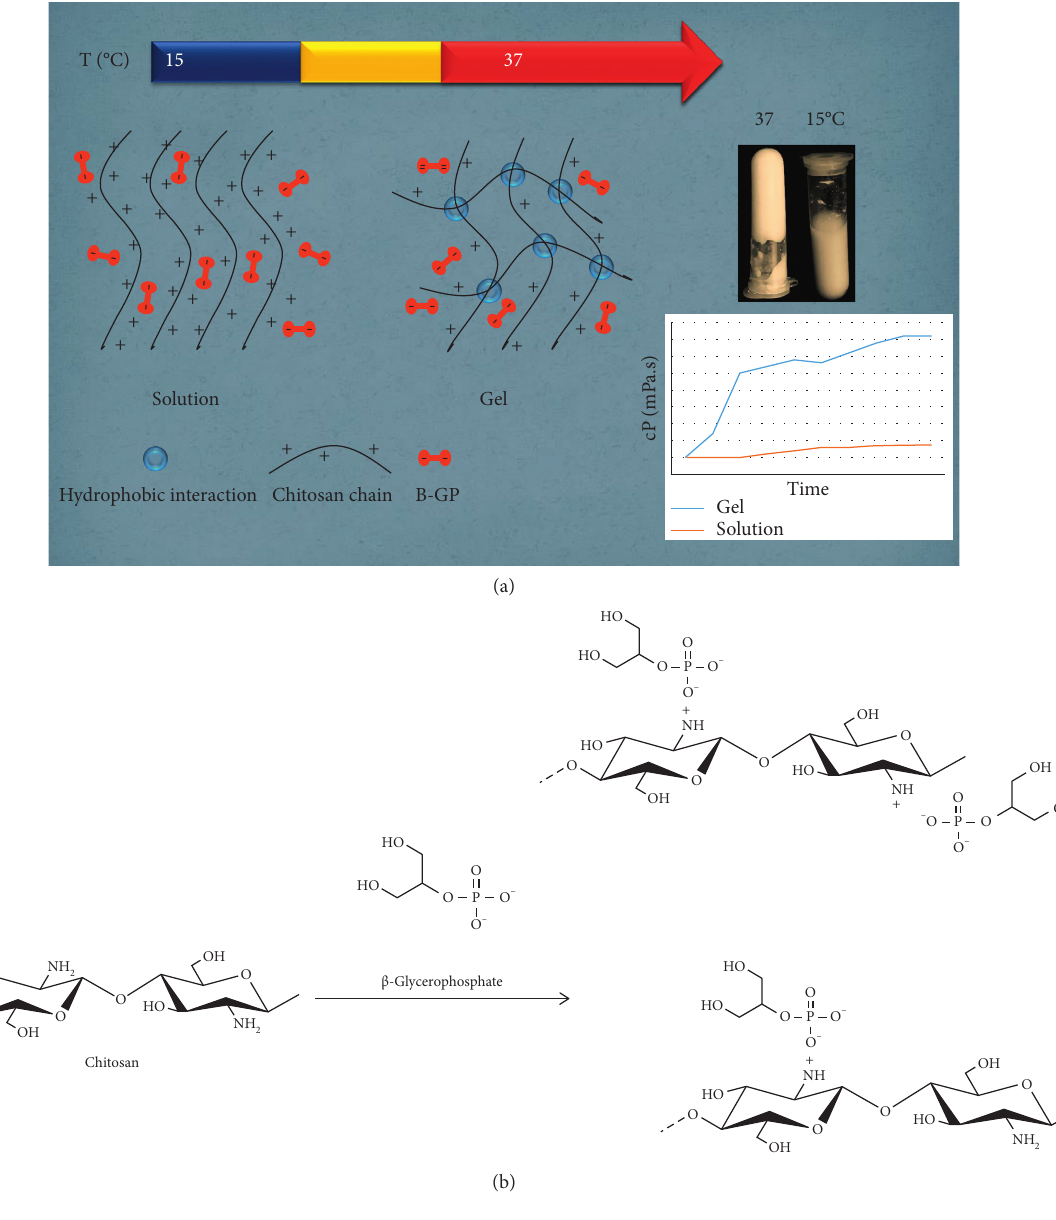
Figure 1: In an acidic environment, chitosan is positively charged (a). Because of the similar groups on the chitosan chain in an acidic environment, the two chains move away from one another, forming an electrostatic repulsion force between the chitosan chains, the water molecules being positioned between the chitosan chains and forming a regular arrangement (b). Adding beta-glycerophosphate, the negative charge of the positively charged chitosan phosphate group forms weak bonds. These weak interactions enhance the water ar- rangement around the chitosan chains. As a result, chitosan dissolves at physiological pH. Nevertheless, with increasing temperature, the regular arrangement of water molecules around the chitosan chains becomes unstable, the polymer-polymer interactions overwhelm the solvent-polymer interactions, and the chitosan precipitates at high temperature in the form of gels